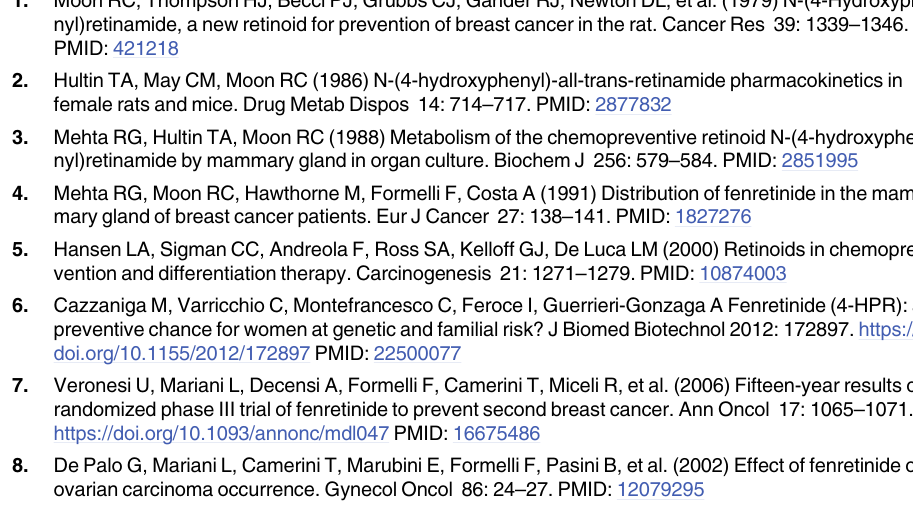
S2 Table. Mass spectrometry data for Fig 3. AUC values for C18 ceramide/C18 dihydrocera- (Sheet 3) measured by AB Sciex API2000 triple quadrupole mass spectrometer are presented for five treatment groups (DMSO, 4-HPR, MPR, 3-keto-HPR and A1120).